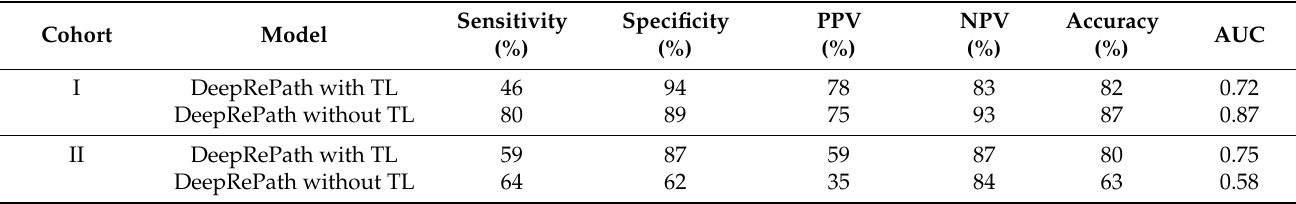
Figure 3. Performance of the DeepRePath model using the architectural and tumor cell network ensemble with data augmentation (100 × and 400 × magnification pathology images) based on the ROC area under the curve (AUC). AUC scores were calculated in cohort II ( n = 91). Table 3. Comparison of the performance of models with/without transfer learning for cohort I (training set) and cohort II (external validation set).